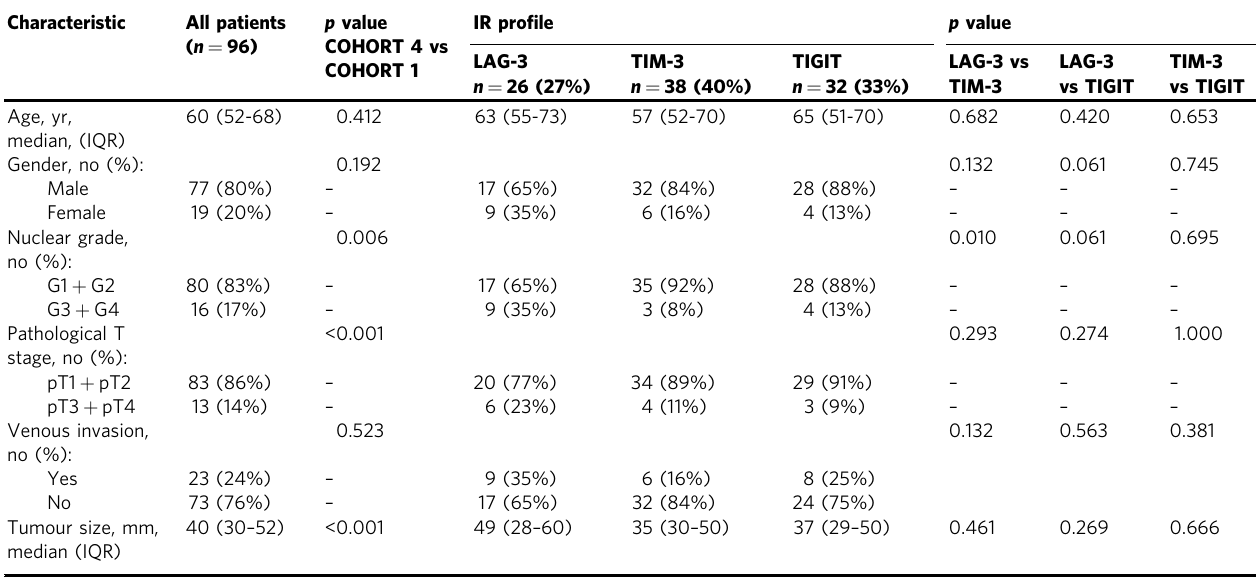
Table 2 Clinicopathological characteristics associated with the phenotypic signatures of the new IRs (LAG-3, TIM-3, and TIGIT) in a validation group of 96 primary ccRCC tumour samples (COHORT